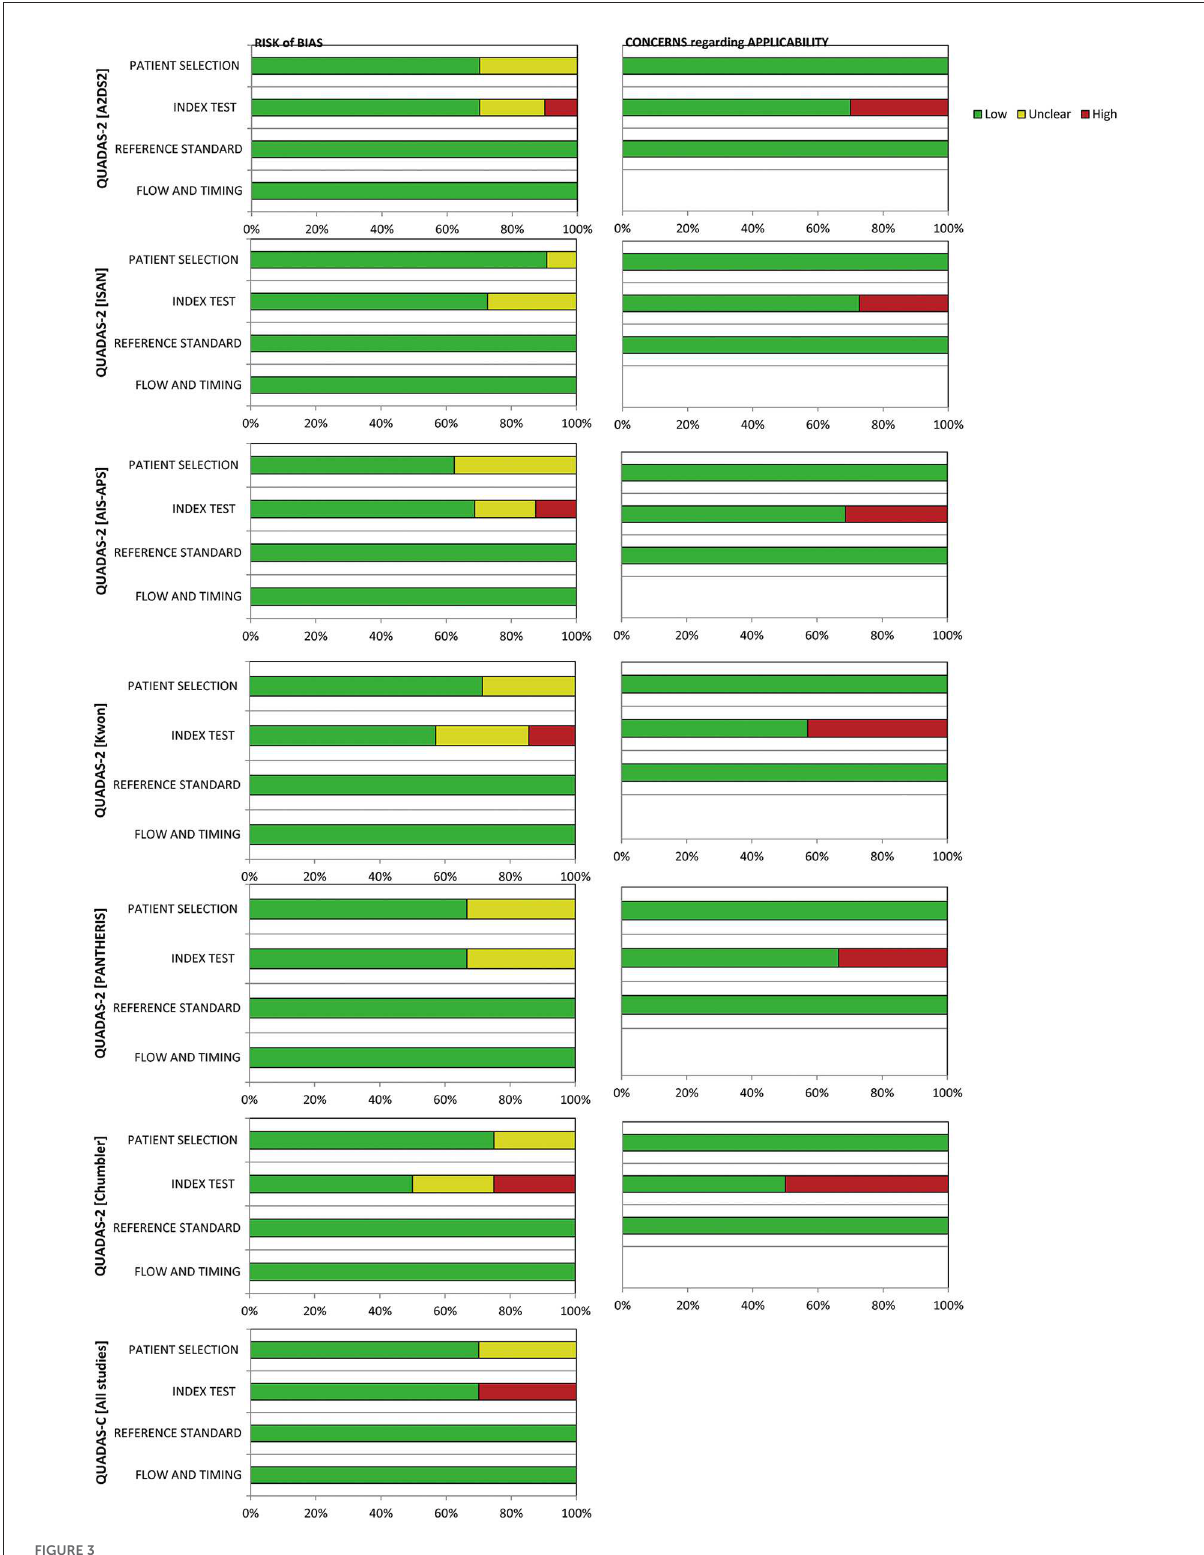
FIGURE3 Risk-of-bias